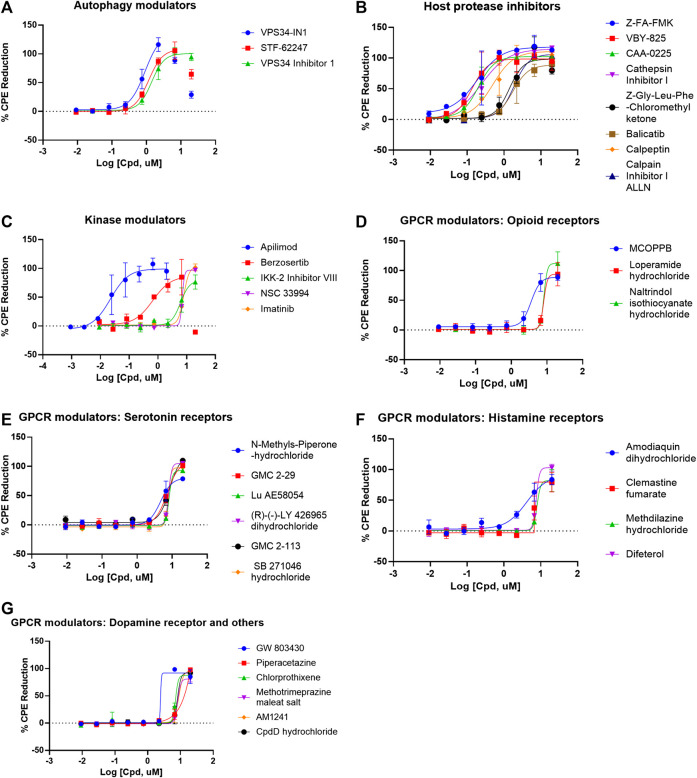
Compounds concentration-response curves in the CPE assay. (A) Autophagy modulators, (B) host protease inhibitors, (C) kinase modulators, (D) opioid receptor modulators, (E) serotonin receptor modulators, (F) histamine receptor modulators, and (G) dopamine and other GPCR receptor modulators. Berzosertib, VPS34-IN1, and STF-62247 showed bell-shaped concentration-responses due to cytotoxicity. No other compounds caused any reduction in viability in the cytotoxicity assay.